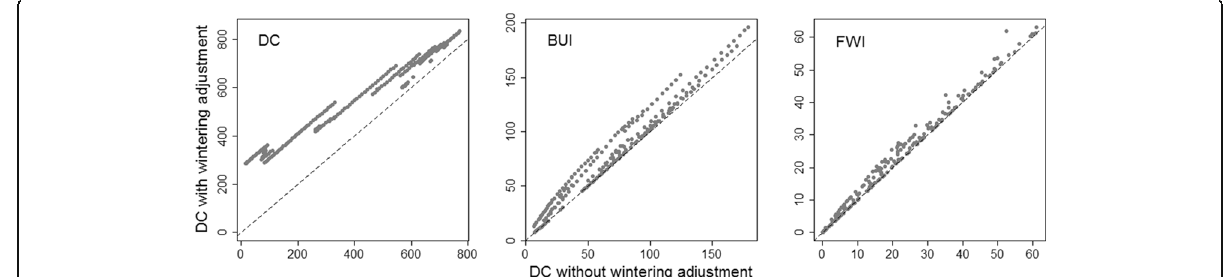
Fig. 4 The impacts of over-wintering drought code (DC) in the calculation of FWI System